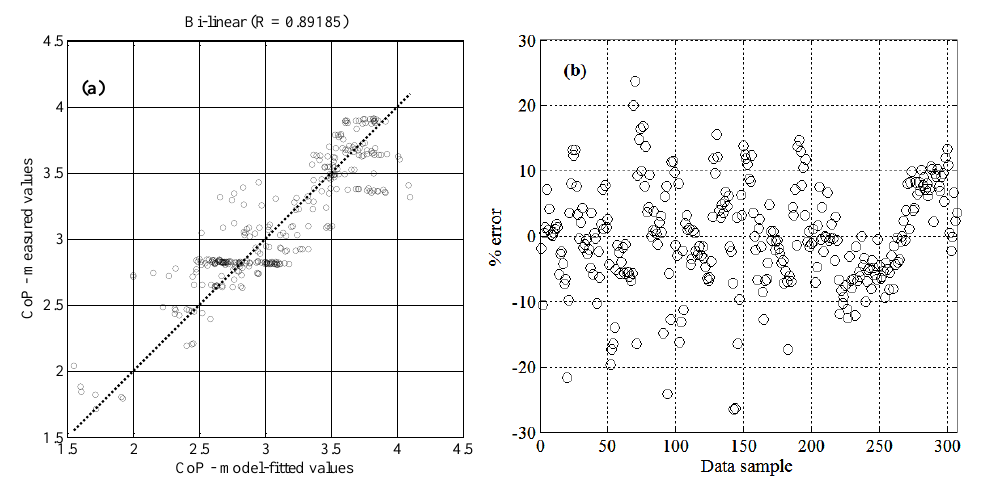
Figure 3. Bi-linear model fitting results. ( a ): Regression plot; ( b ): Target-model errors (%).